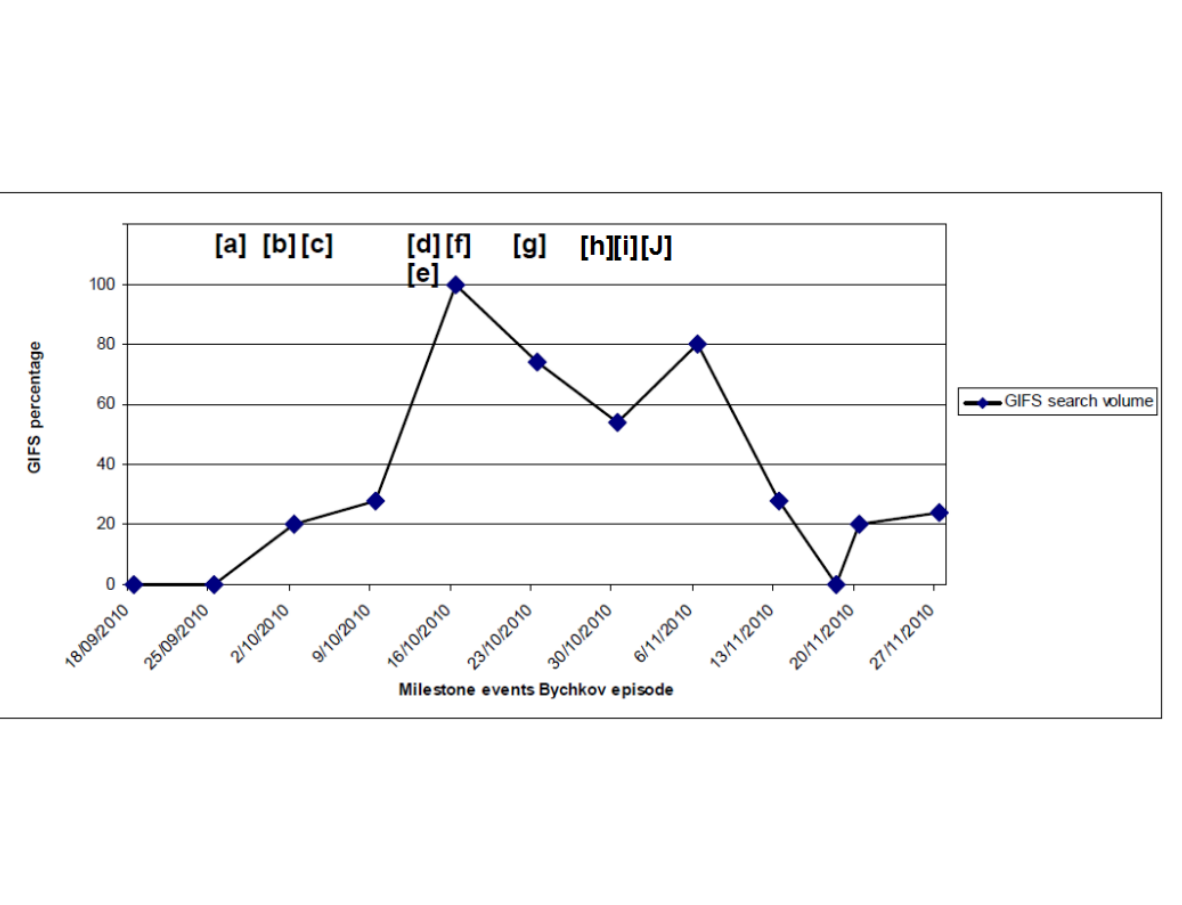
Figure 1. Google Insights for Search (GIFS) and milestone events in the Bychkov episode. [a] 25 September 2010 Radio Echo Moscow national broadcast about Bychkov episode 1 [11] [b] 30 September 2010 Egor Bychkov Youtube public message posted [67] [c] 2 October 2010 Radio Echo Moscow national broadcast about Bychkov episode 2 [68] [d] 12 October 2010 Nizhny Tagil Court sentences Bychkov to 3.5 year prison term [69]